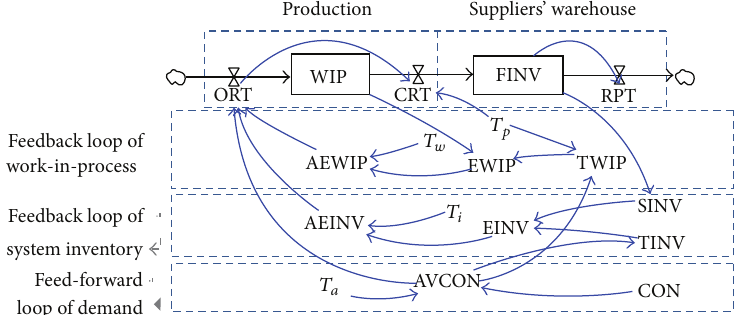
Figure 9: VMI&TPL integrated operation process.